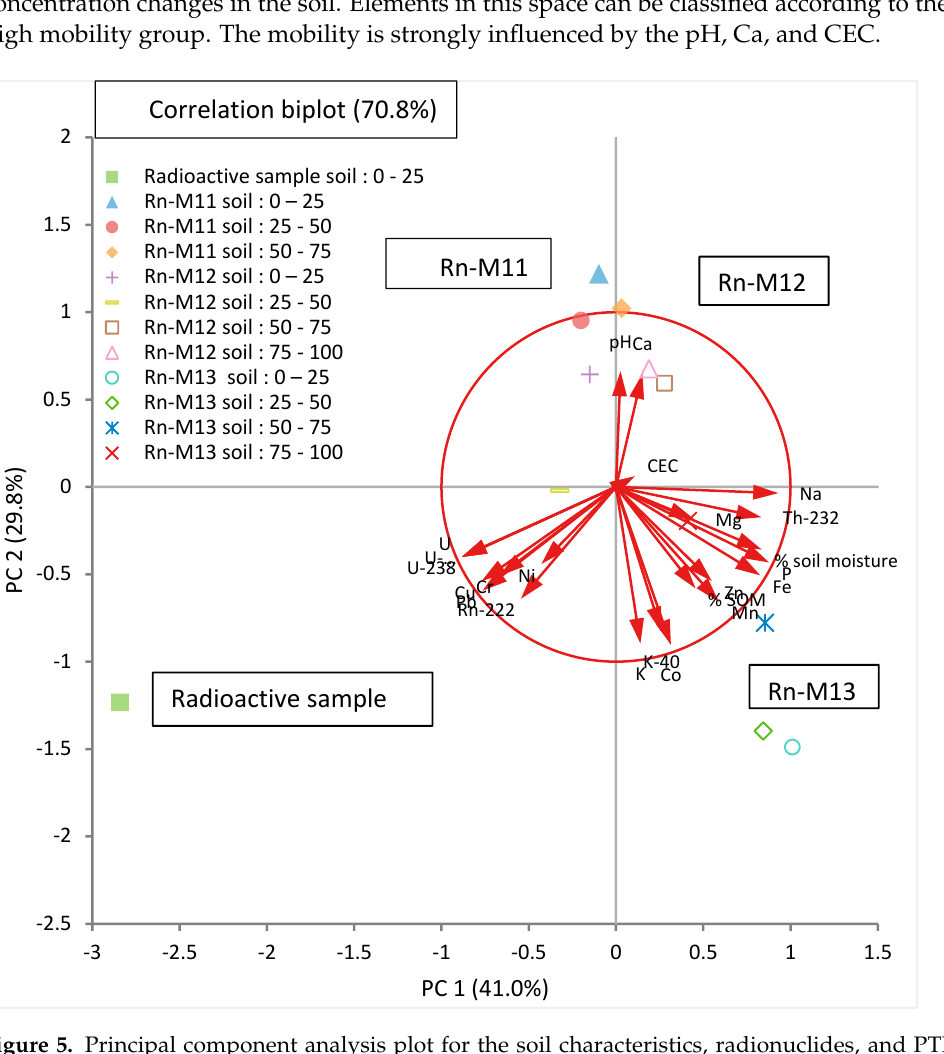
Figure 5. Principal component analysis plot for the soil characteristics, radionuclides, and PTEs in soil.